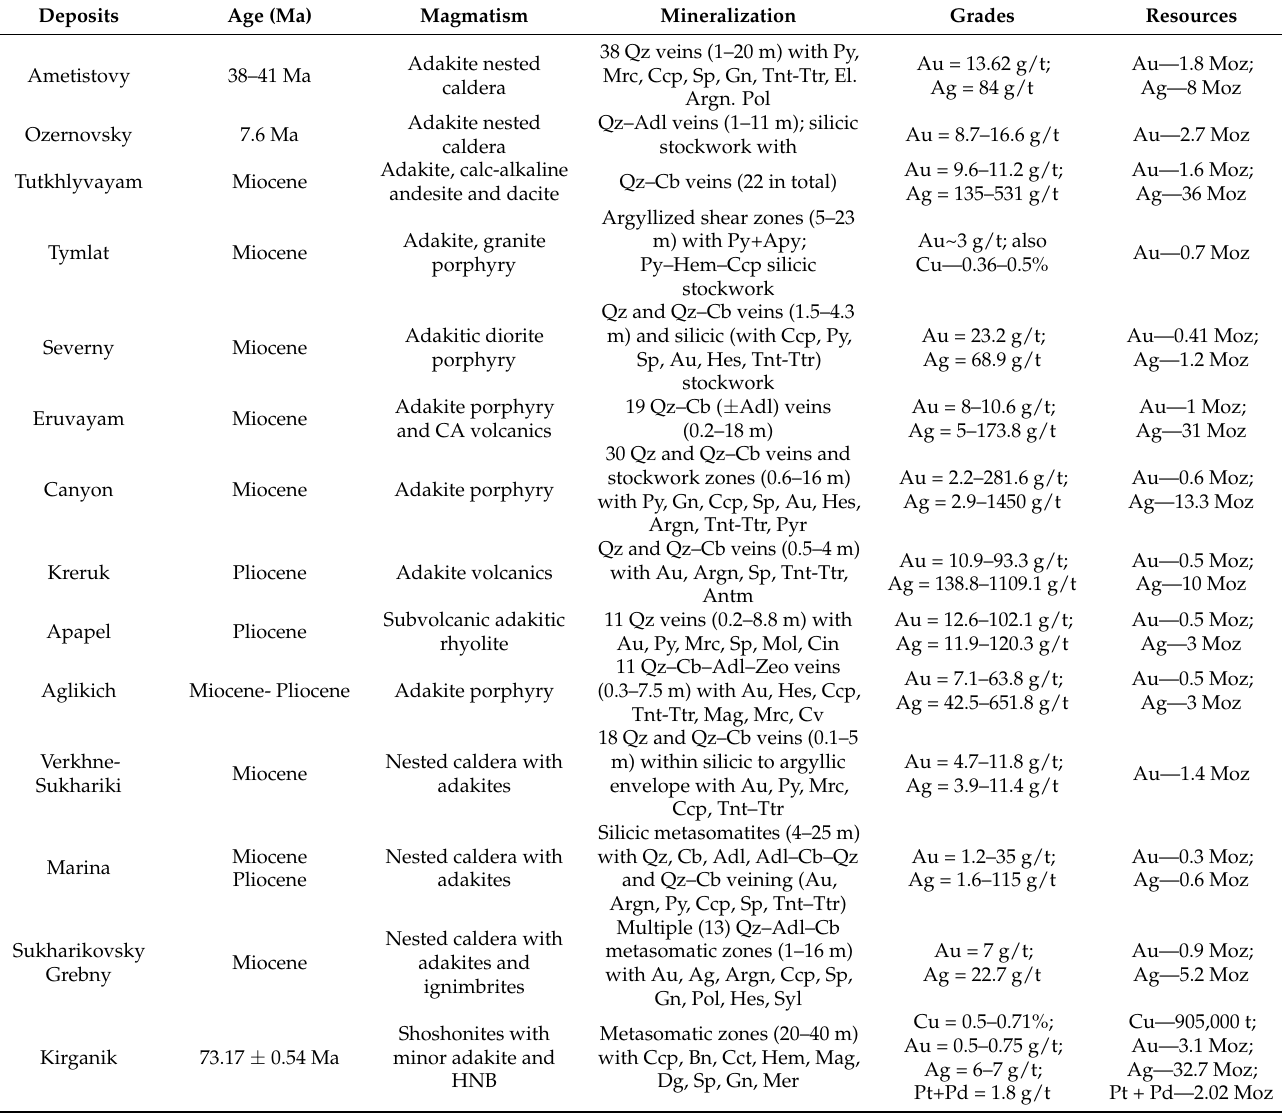
Table 5. Au–Cu (Ag, Mo) mineralization associated with adakite/HNB magmatism in